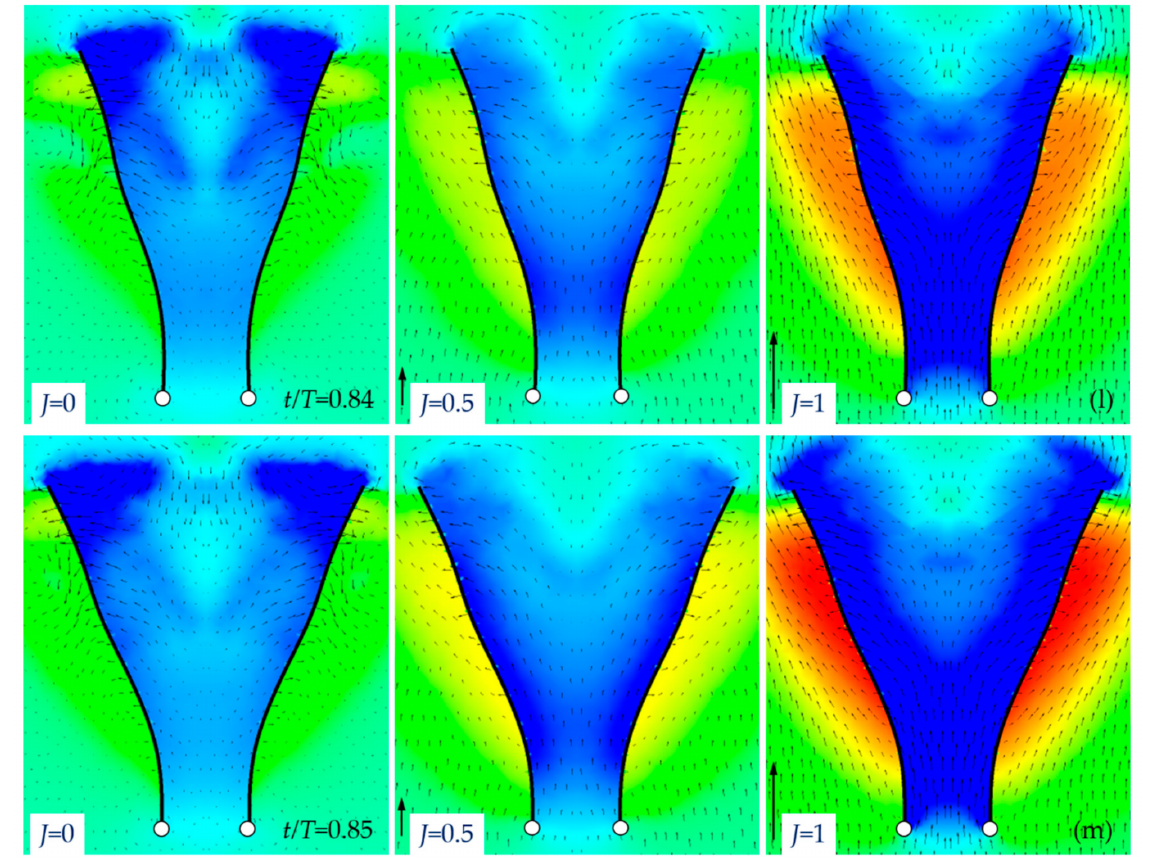
Figure 23. Flow fields in 25% c m -plane during up-stroke reversal; ( a – d ) Up-stroke clap; ( e – m ) Down- stroke fling. For all values of J , the wing distance is 16 mm. The wing roots are marked with white